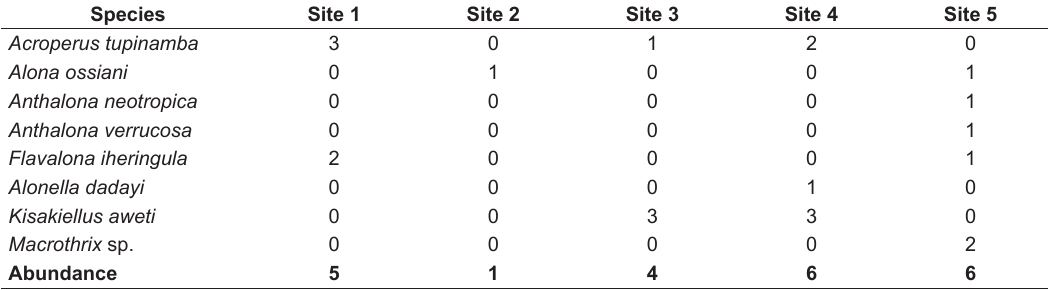
Table 1. Composition of species with Cladocera abundance values of the five streams located in the transition zone between the Amazon and Cerrado Biomes.